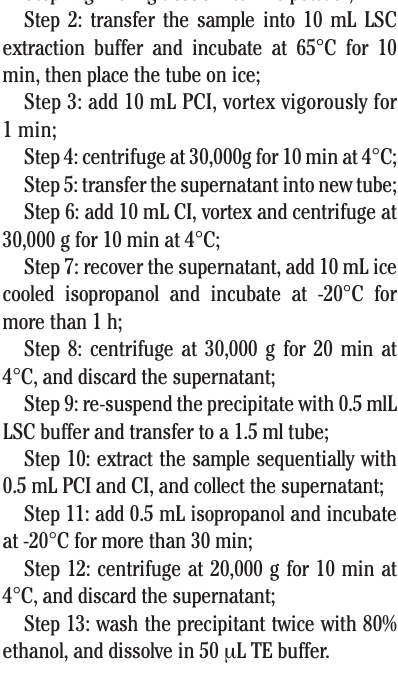
spin column for small scale extraction and dou-